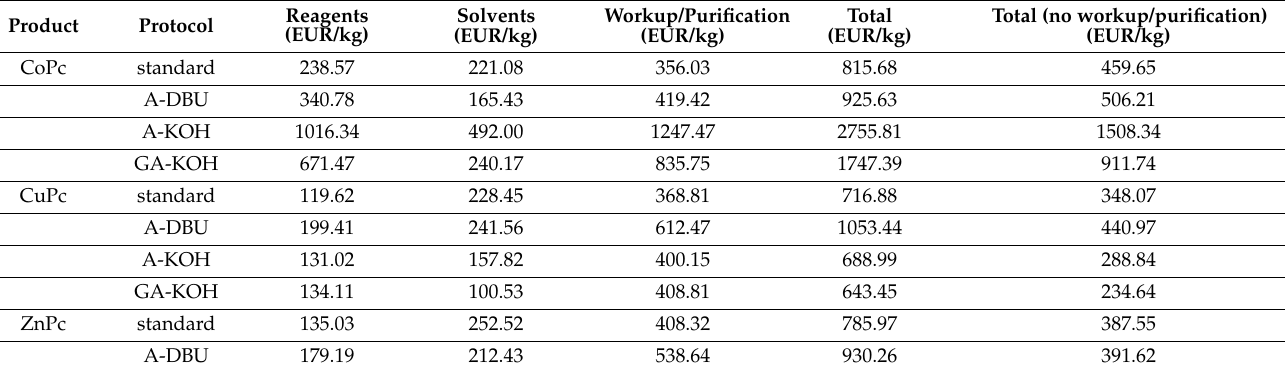
Table 4. Cost analysis for unsubstituted